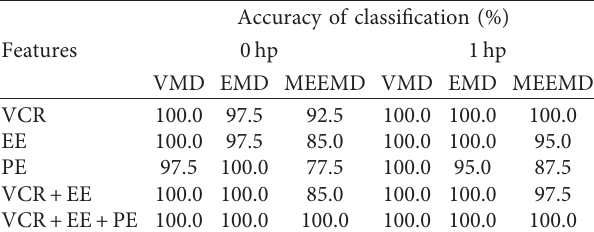
Table 4: The classification results of 0hp and 1hp